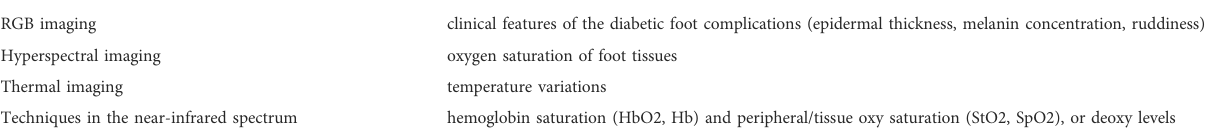
TABLE 1 Sensing techniques for DFU